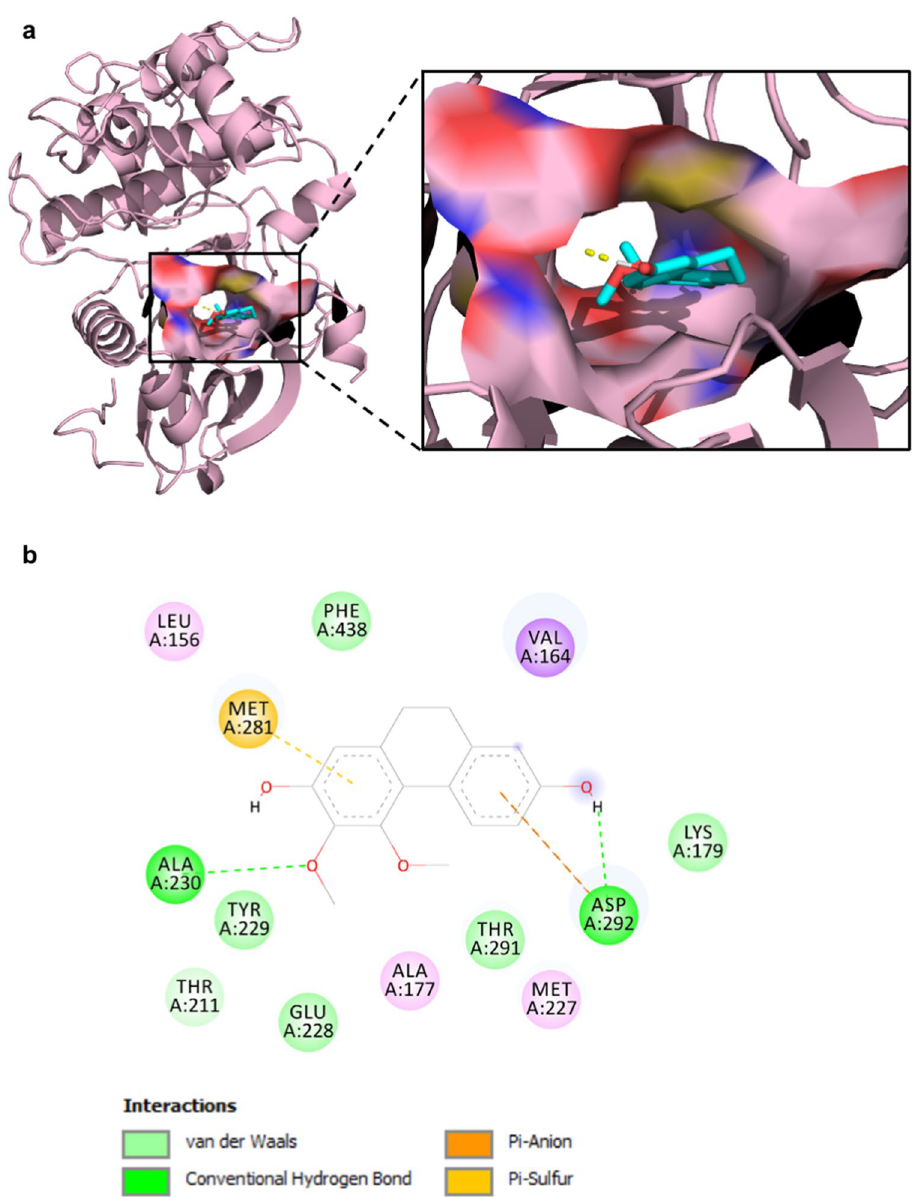
Figure 5. ETD directly binds to Akt. ( A ) Molecular docking analysis of ETD and Akt was performed by AutoDock4.2 and PyMOL program. ( B ) A schematic diagram, created by BIOVIA Discovery Studio Visualizer 2017, of the interacting residues between ETD and Akt is shown. Hydrogen bonds are displayed in green. The van der Waals interactions are shown in light green. The anion-π and sulfur-π interactions are shown in orange and yellow,